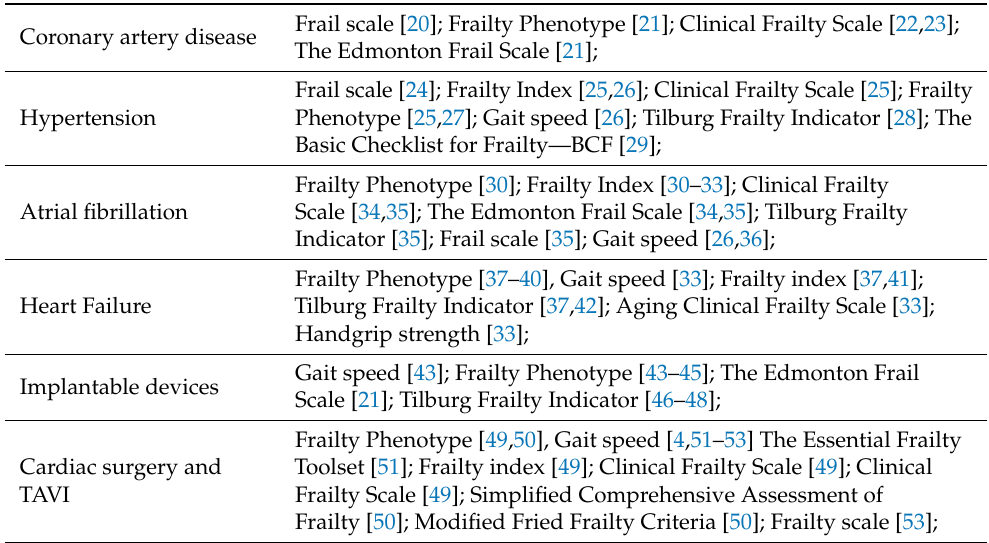
Table 1. Tools for assessing Frailty syndrome in various groups of CVD, based on articles reviewed. Coronary artery